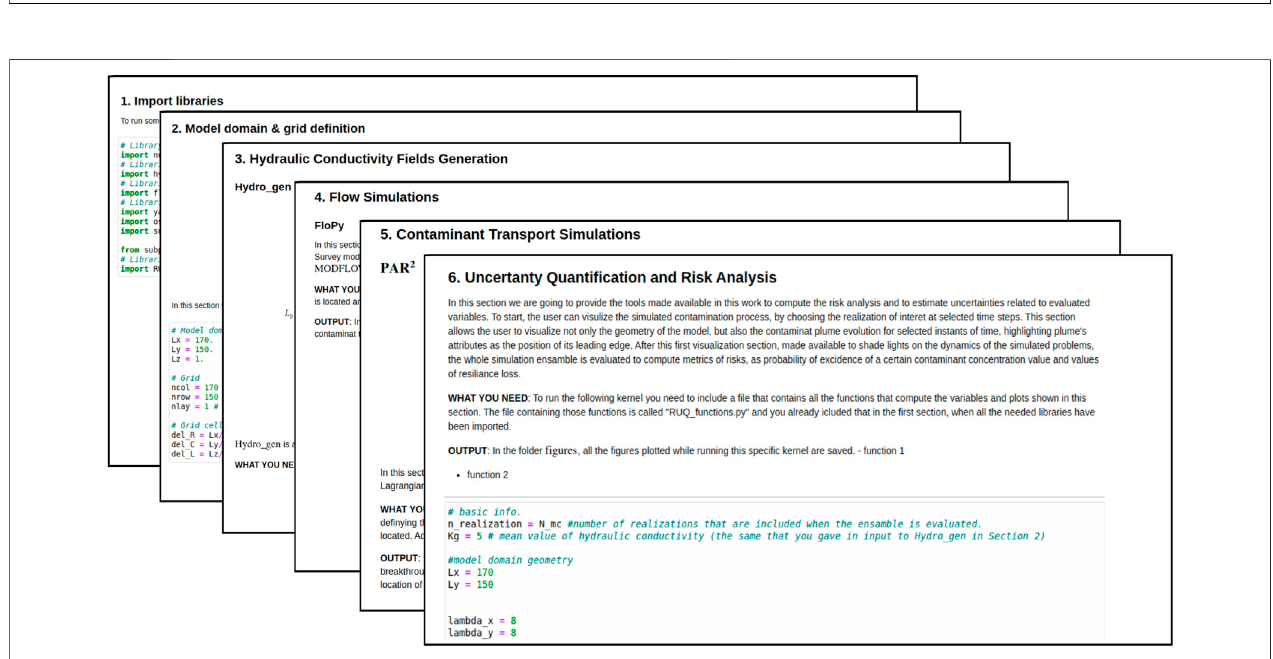
FIGURE2| ExamplesofJupyterNotebookcodecellscorresponding tothenumbered processes (see Figure1 ).Detaileddescriptionsareincluded ineachcellso that users can easily reproduce the results of the tutorial presented in this study.